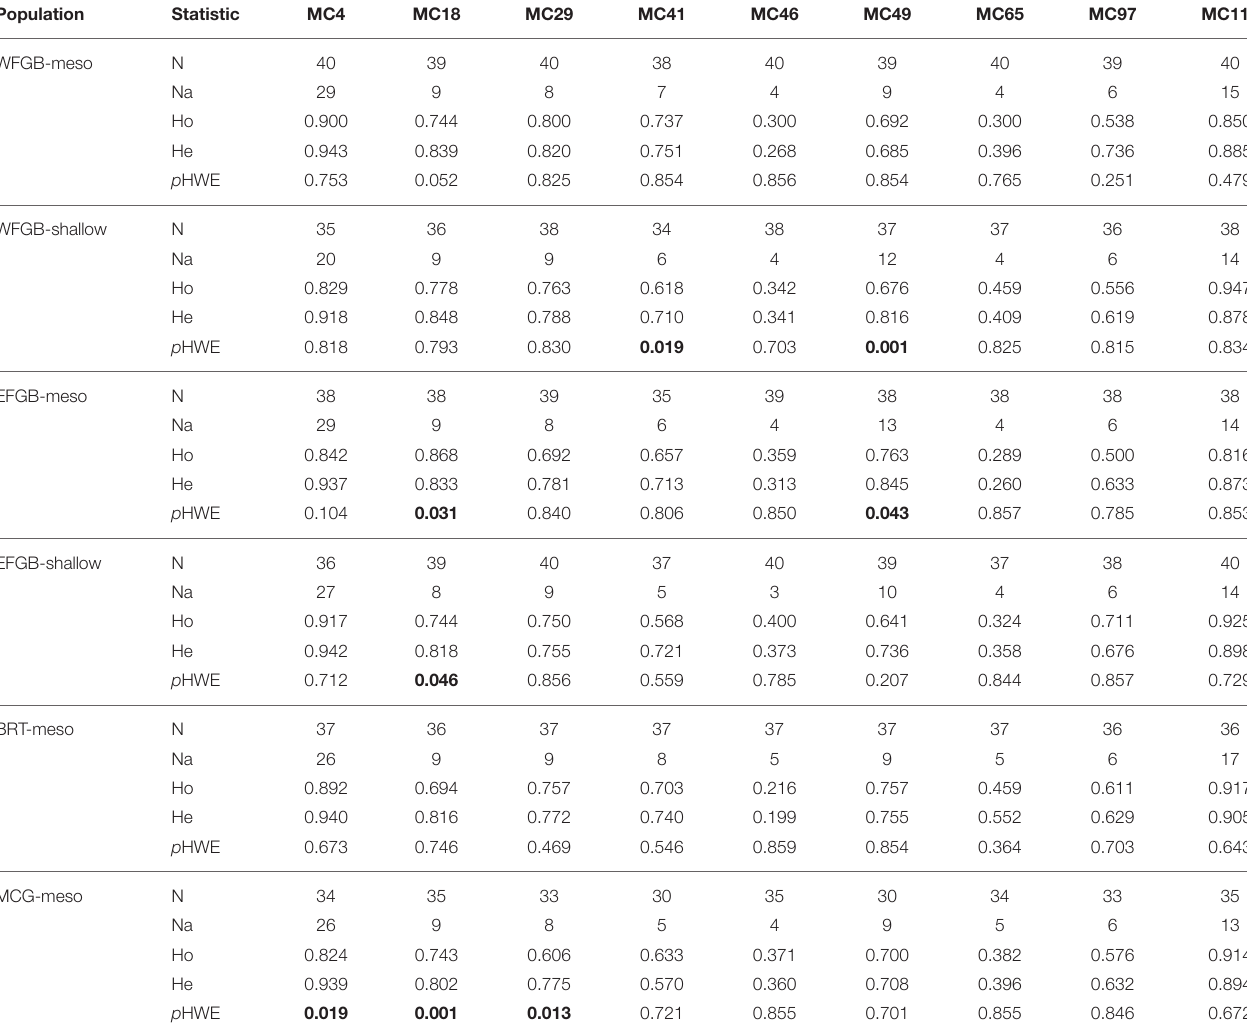
TABLE 2 | Summary of genetic diversity statistics across loci and populations.